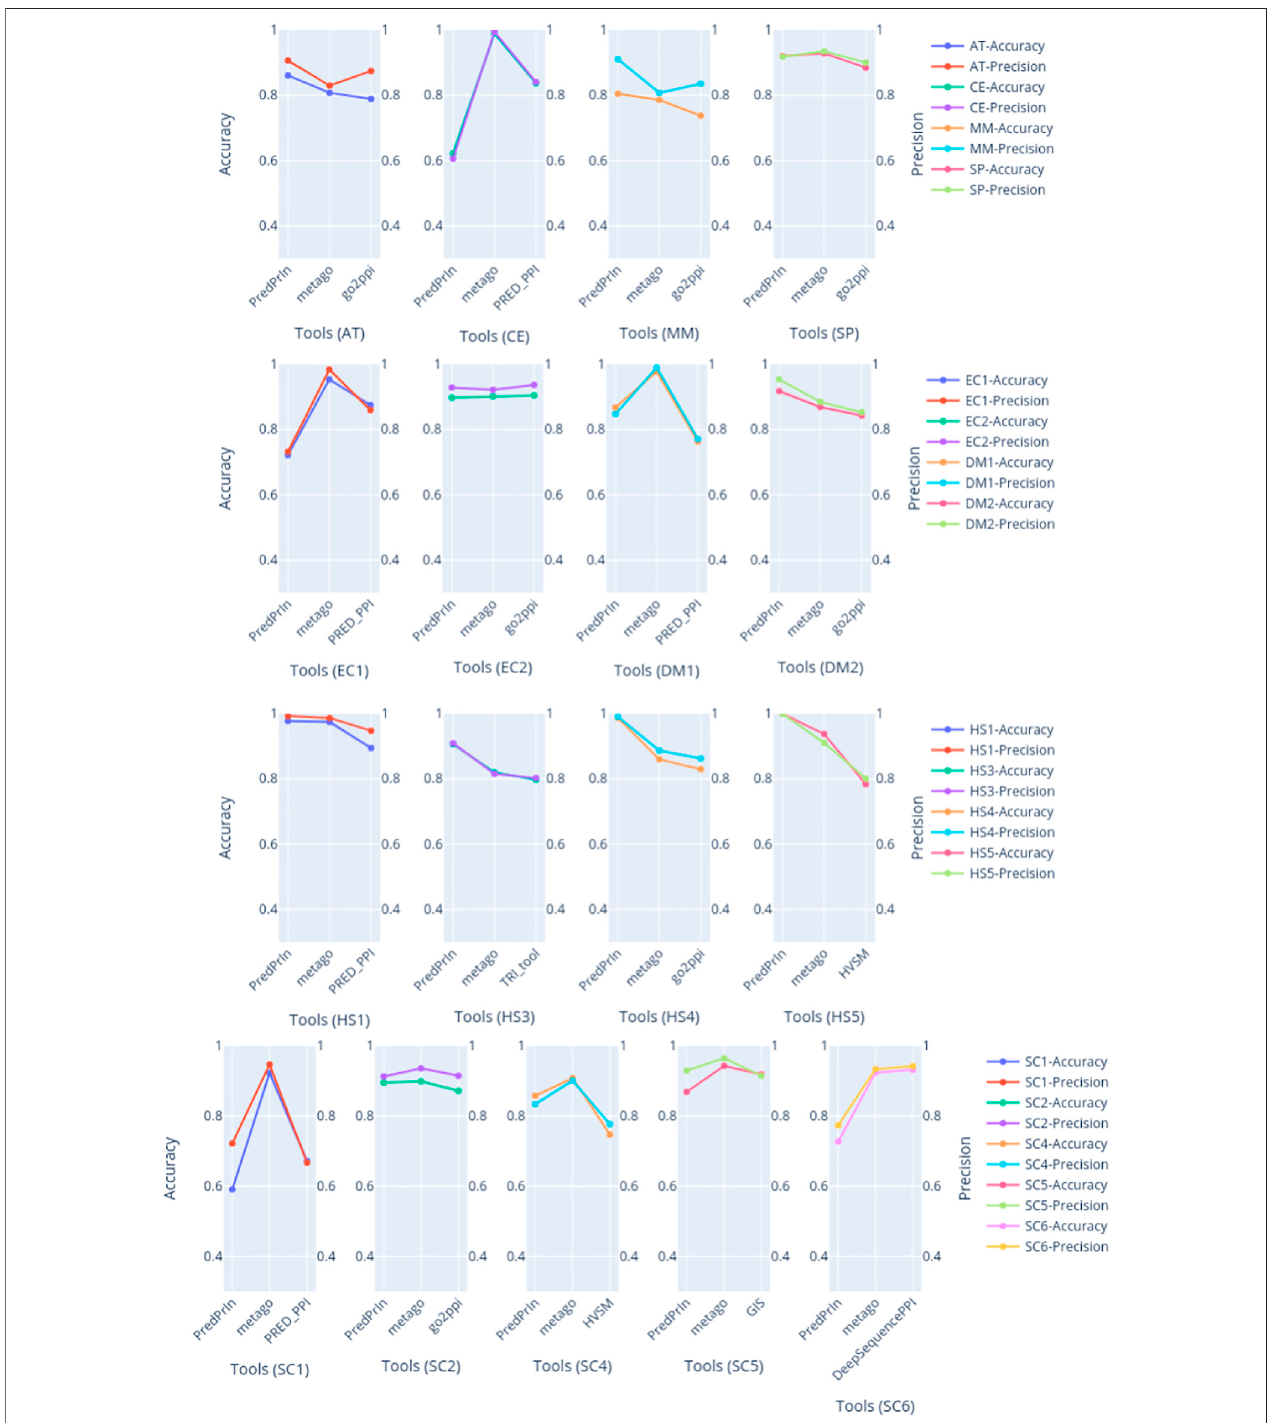
FIGURE 2 | The plots are grouped by dataset, compared with accuracy and precision metrics between PredPrIn and the other tools according to each species datasets. Theleft y axis represents the accuracy values, and the right y axis refers tothe precision ones. The colorsare repeated according toeach lineof plots. The fi rst lineofplotsaretheisolateddatasetsforAT,CE,MMandSPspecies,thesecondlinearetheplotsforthepairsofdatasetsbelongingtoDMandEC,thethirdlinecontains the plots for four datasets belonging to HS species. Finally, the last line represents the plots of the fi ve datasets of SC species.